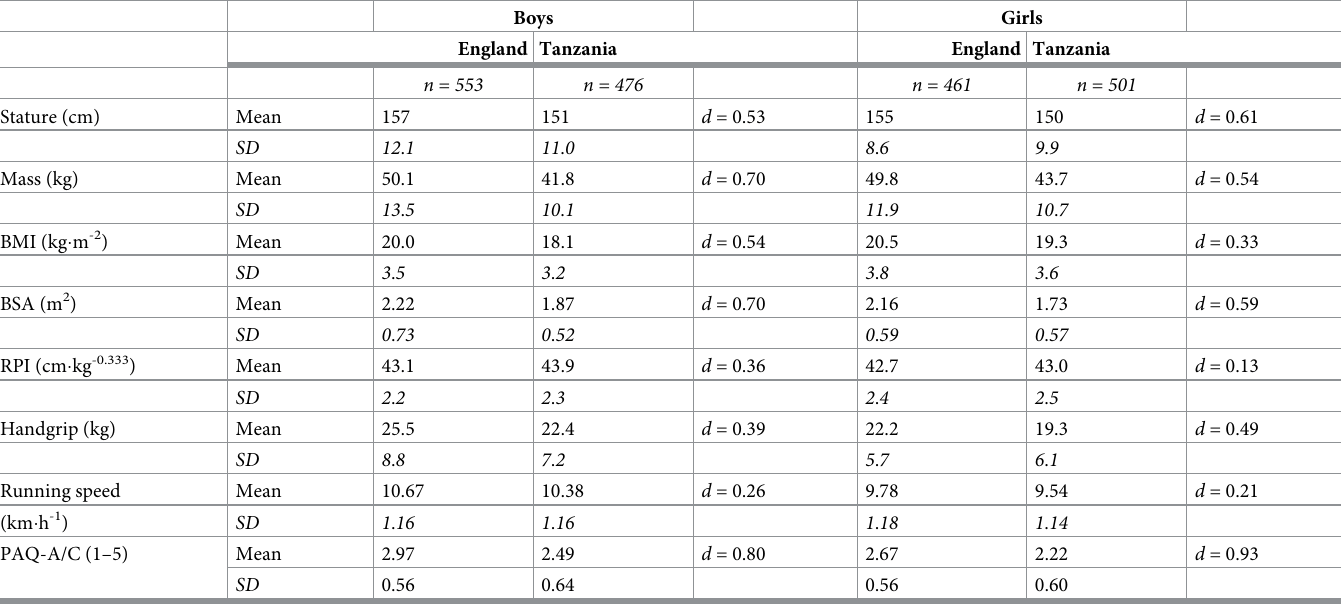
Table 1. Differences in body size, physical fitness and physical activity of 10–15 year olds from England and